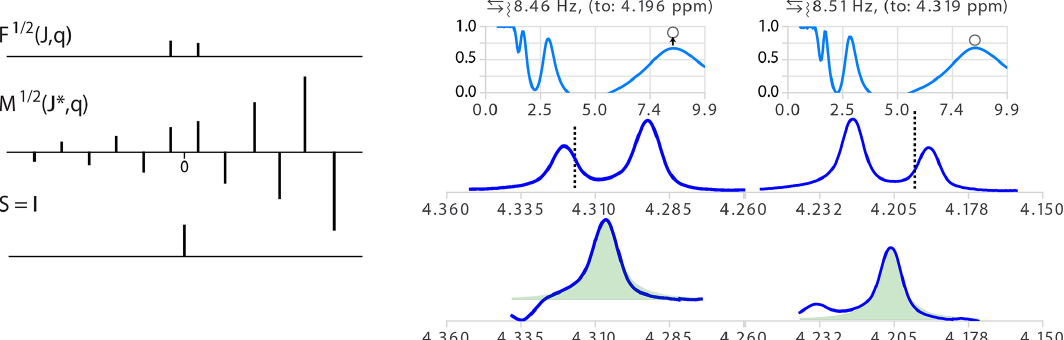
Figure 7. (Left) Illustration of the model function of a doublet with non-equal amplitude F 1 / 2 ( J,θ ) and its inverse function M 1 / 2 ( J ∗ ,θ ). The amplitude ratio of the absolute values of two consecutive δ in M is the inverse of the ratio in F 1 / 2 ( J,θ ). (Right) Analysis of two multiplet structures of an AB spin system (300MHz spectrum of a taxol sample). (cid:49)δ/J = 6.6, 2 θ = 8.6deg . and the ratio of signal amplitudes r = 0.74. The error in the determination of partner chemical shift was about 0.01ppm. The open circles in the quality functions indicate the level of the measure of the quality function after optimization of θ .